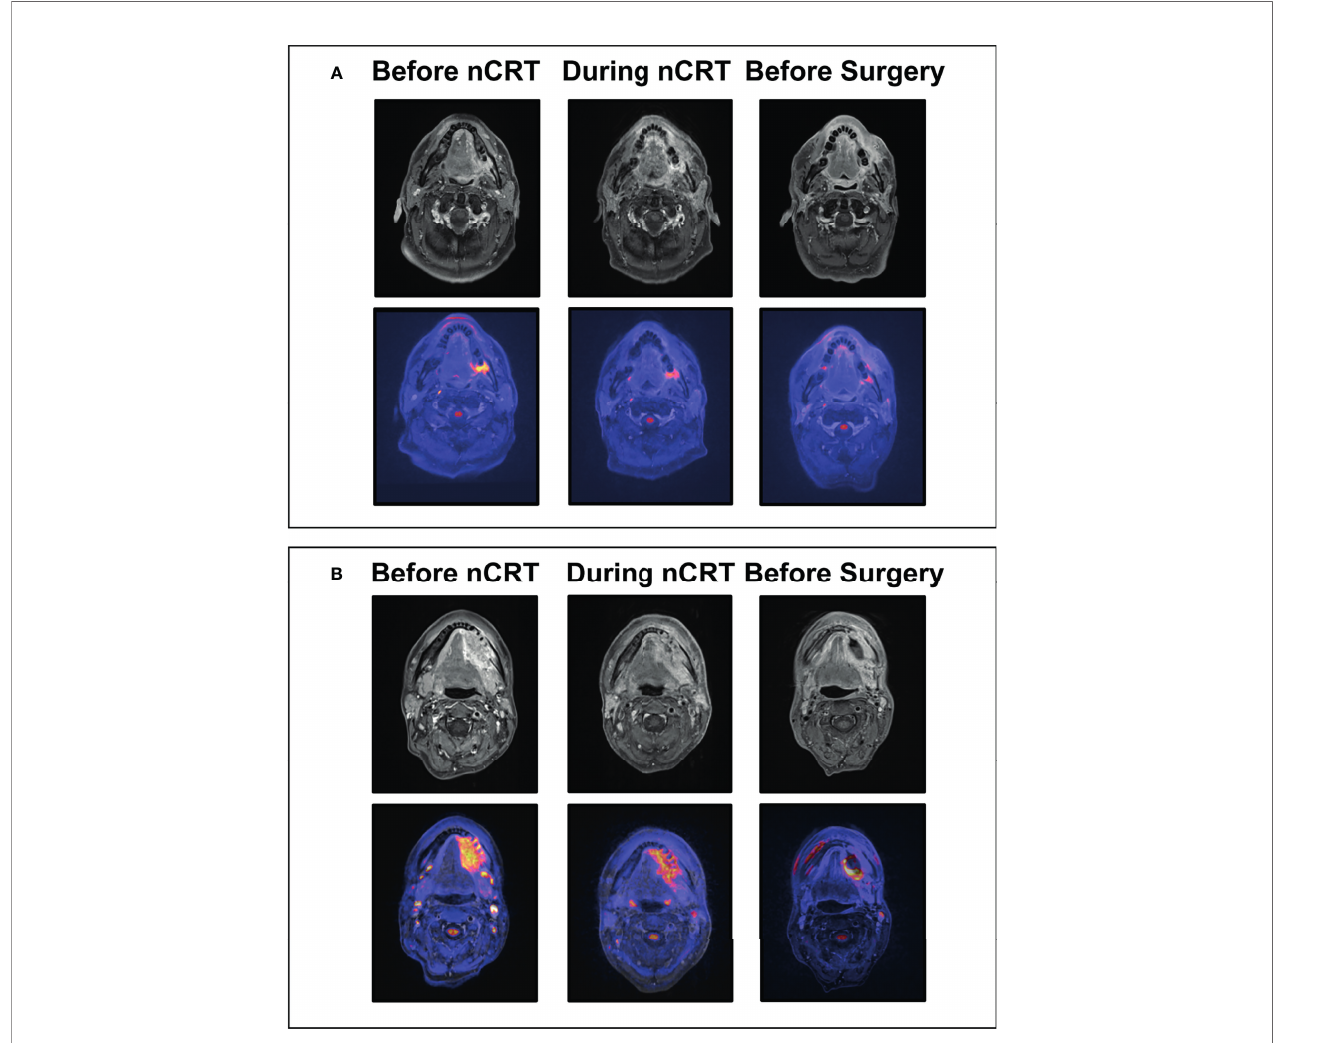
FIGURE 2 | Exemplary MRI Images of Clinical Responses to Neoadjuvant Chemoradiotherapy. (A) Exemplary images of a 55-year old patient with left-sided squamous cell carcinoma of the oral cavity before and during chemoradiotherapy (day 15), and prior to surgery; The top row shows representative axial gadolineum- enhanced T1-weighted images with continuous decrease in size and contrast enhancement resulting in complete clinical response prior to surgery of the primary tumor at the left retromolar region; The bottom row shows corresponding fused diffusion-weighted - gadolineum-enhanced T1-weighted images with decreasing diffusion restriction of the tumor region resulting in complete clinical response prior to surgery. (B) Exemplary images of a 49-year old patient with left-sided squamous cell carcinoma of the oral cavity before and during chemoradiotherapy (day 15), and prior to surgery; The top row shows representative axial gadolineum-enhanced T1-weighted images with continuous decrease in size and contrast enhancement. Markable residual tumor with contrast enhancement at the left mandibular region prior to surgery; The bottom row shows corresponding fused diffusion-weighted - gadolineum-enhanced T1-weighted images with decreasing but residual diffusion restriction of the tumor region; nCRT, Neoadjuvant